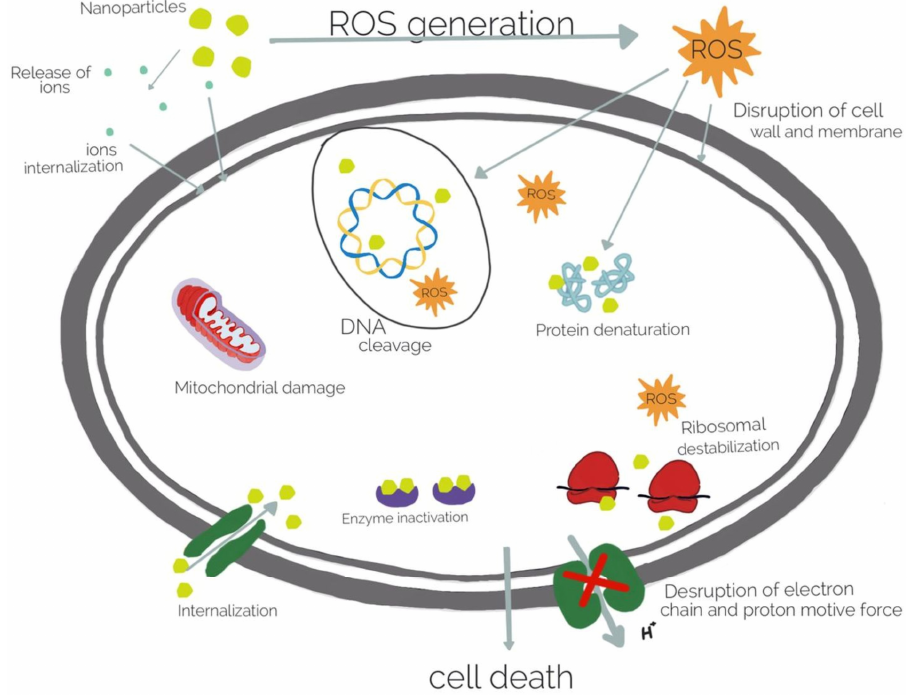
Figure 4. Antibacterial mechanisms of metal nanoparticles. Reprinted from [118].